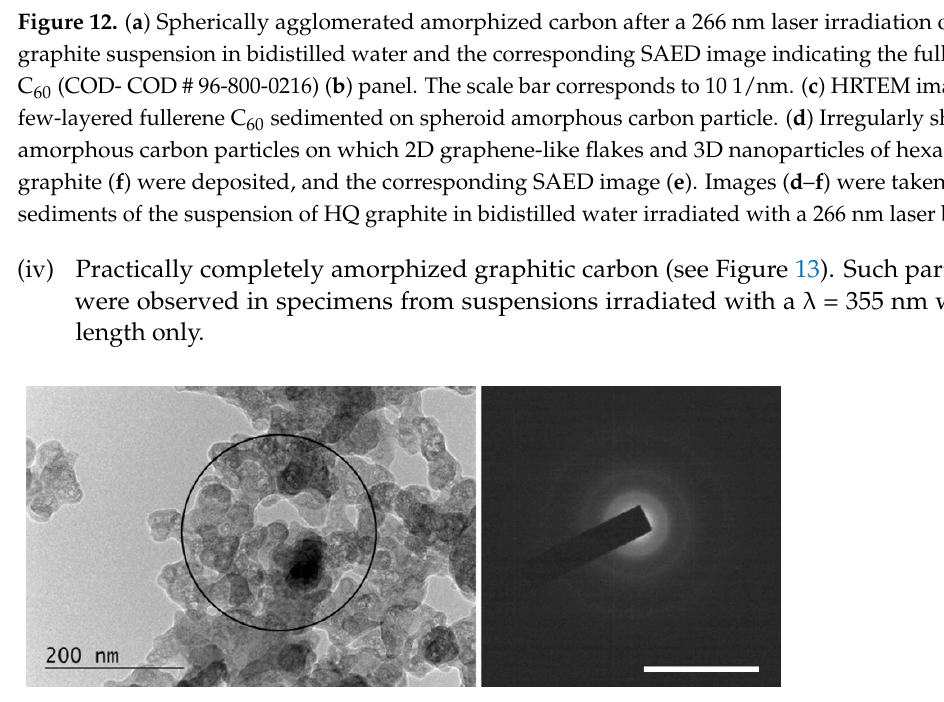
Figure 13. An overview image of completely amorphized graphitic carbon sedimented after irradiation of a suspension of HQ graphite in bidistilled water with a 355 nm laser. The scale bar on the SAED pattern corresponds to 10 1/nm.